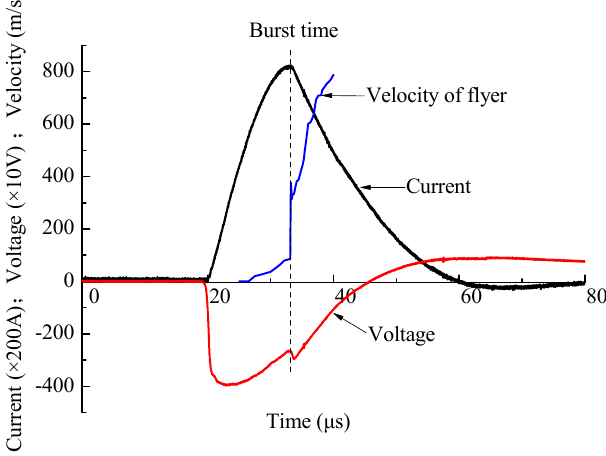
Figure 3. Voltage, current, and velocity traces with 8 kJ energy input.